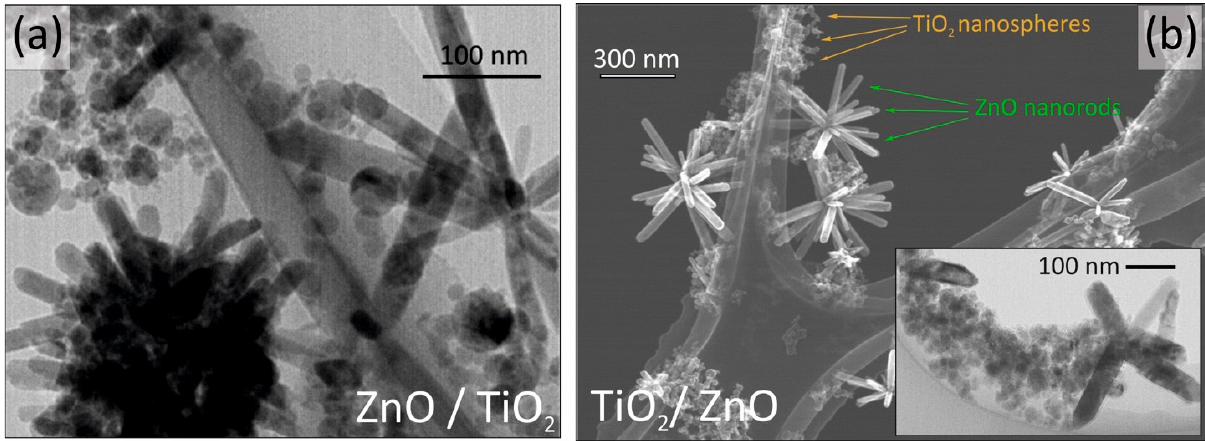
2 (red) and TiO 2 /ZnO (blue).